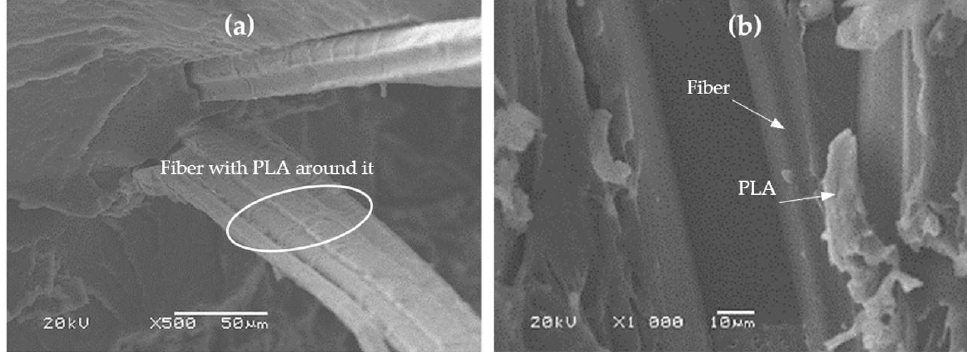
Figure 9. Nettle fiber imbedded in PLA ( a ) compared to a smoother fiber, where PLA did not cling well ( b ).